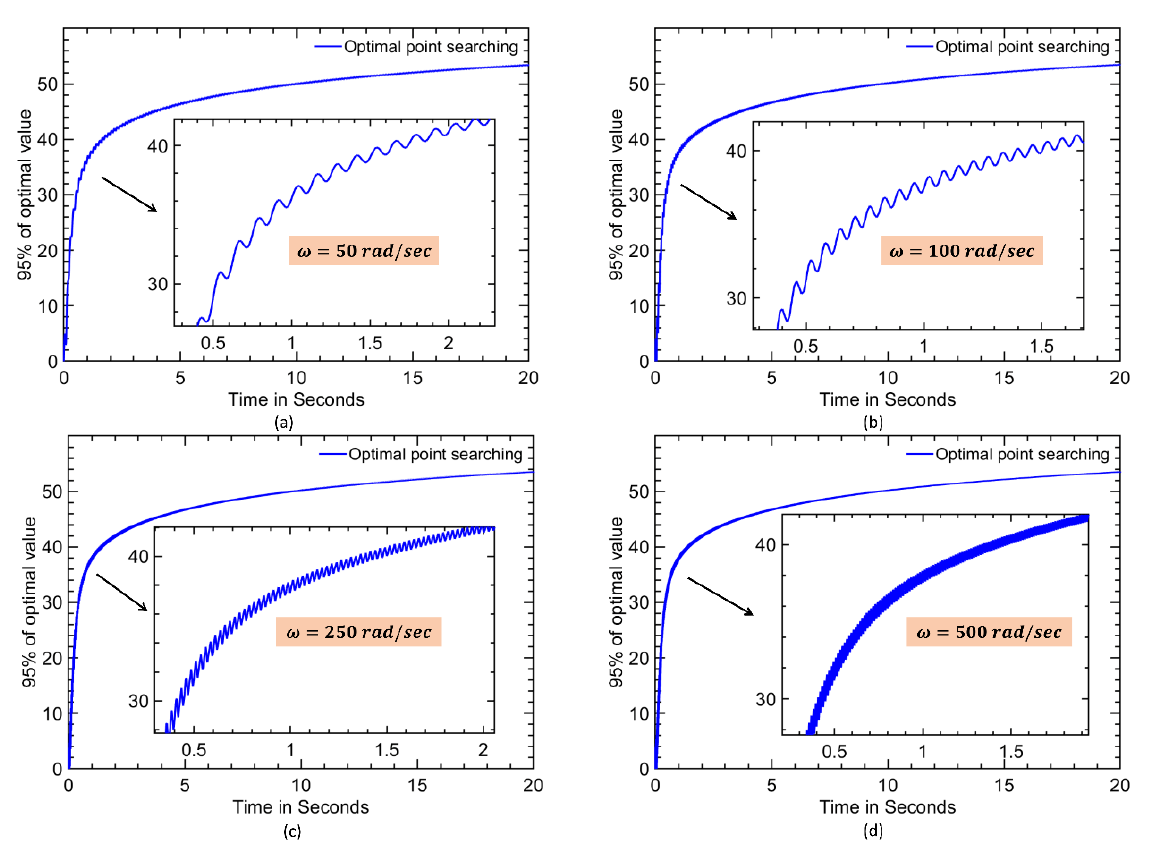
Figure 9. Optimal perturb frequency 𝜔 searching for fast settling with a gap current of 8.5 A and ( a ) ω = 50 rad/s, ( b ) ω = 100 rad/s, ( c ) ω = 250 rad/s, and ( d ) ω = 500 rad/s.